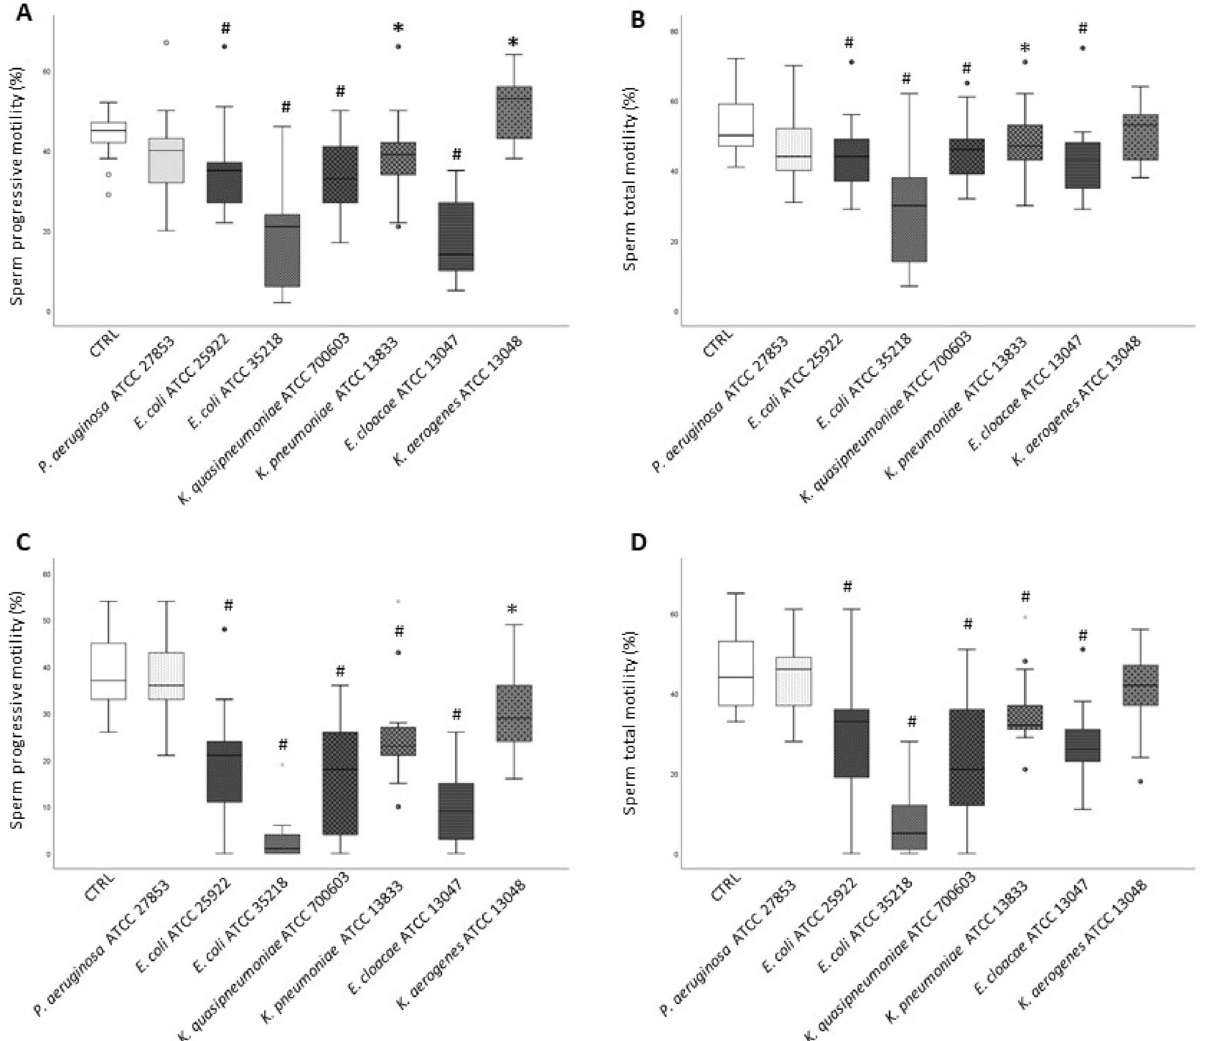
Figure 1. Box-plots representing the effect of 1 (n = 13, panels A and B ) and 3 (n = 16, panels C and D ) hours in vitro incubation (37 °C, 5%CO 2 ) of whole semen samples with various bacterial strains ( P. aeruginosa ATCC 27853, E. coli ATCC 25922, E. coli ATCC 35218, K. quasipneumoniae ATCC 700603, K. pneumoniae ATCC 13883, E. cloacae ATCC 13047 and K. aerogenes ATCC 13048) on sperm progressive ( A and C ) and total motility ( B and D ). Wilcoxon test, *p < 0.05; #p < 0.01 versus